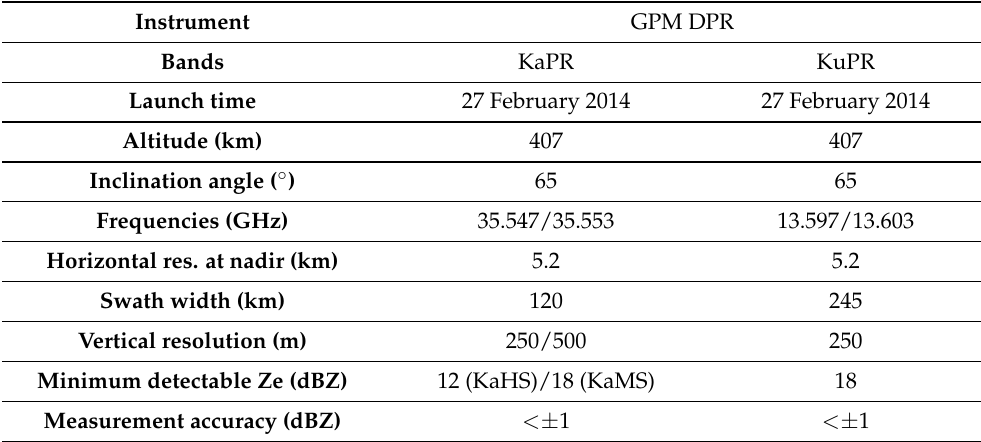
Table 3. Summary of the characteristics of the GMP Dual-frequency Precipitation Radar (DPR). The GPM KuPR minimum threshold is closer to 12–13 dBZ than the official 18 dBZ in the table (from [71]). Instrument GPM DPR Bands KaPR KuPR Launch time Altitude (km)